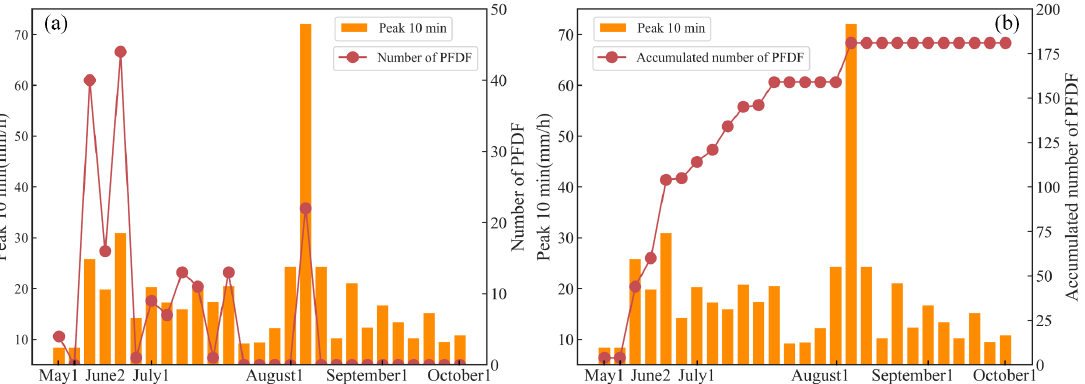
Figure 16. Field survey results of PFDF development laws in the first rainy season after the fire. ( a ) The temporal evolution law of occurrence number of PFDF and its rainfall threshold (max 10 min), ( b ) the temporal evolution law of cumulative occurrence number of PFDF and its rainfall threshold (max 10 min).